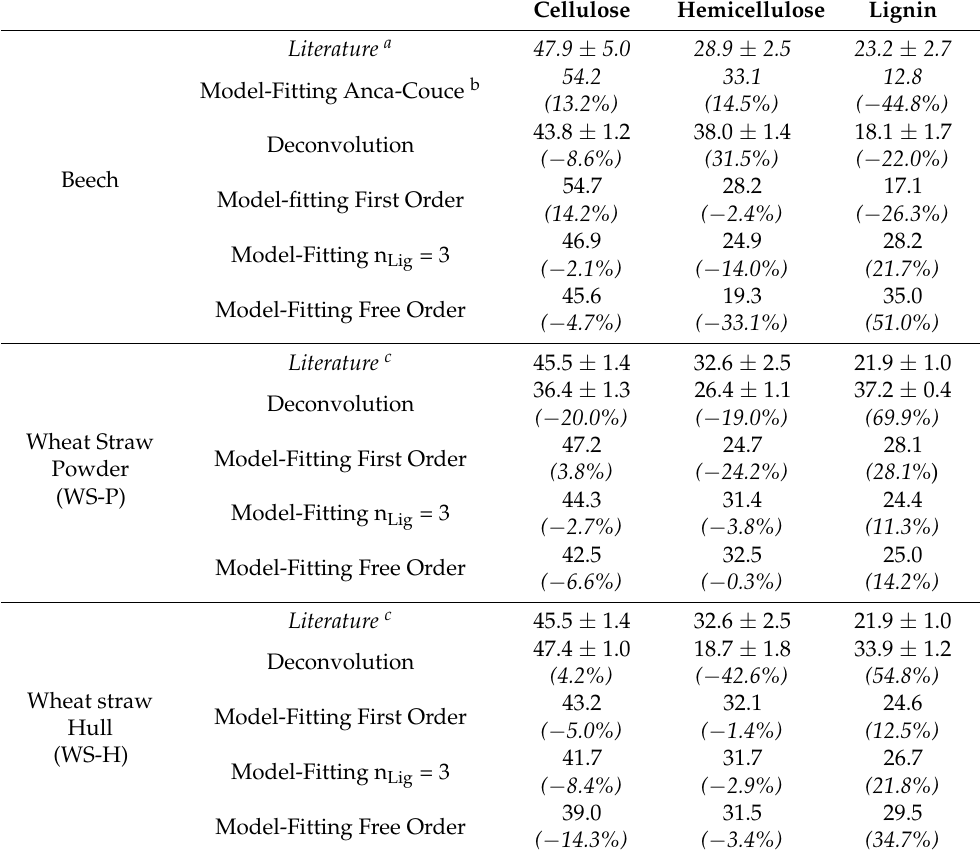
Table 6. Comparison of the presented estimates for the lignocellulosic composition of the feedstocks in this study (wt.% daf.). Values in italics represent the deviation from the literature values. All values were extrapolated to 100%, and the presence of extractives, lipids, and protein content was disregarded.